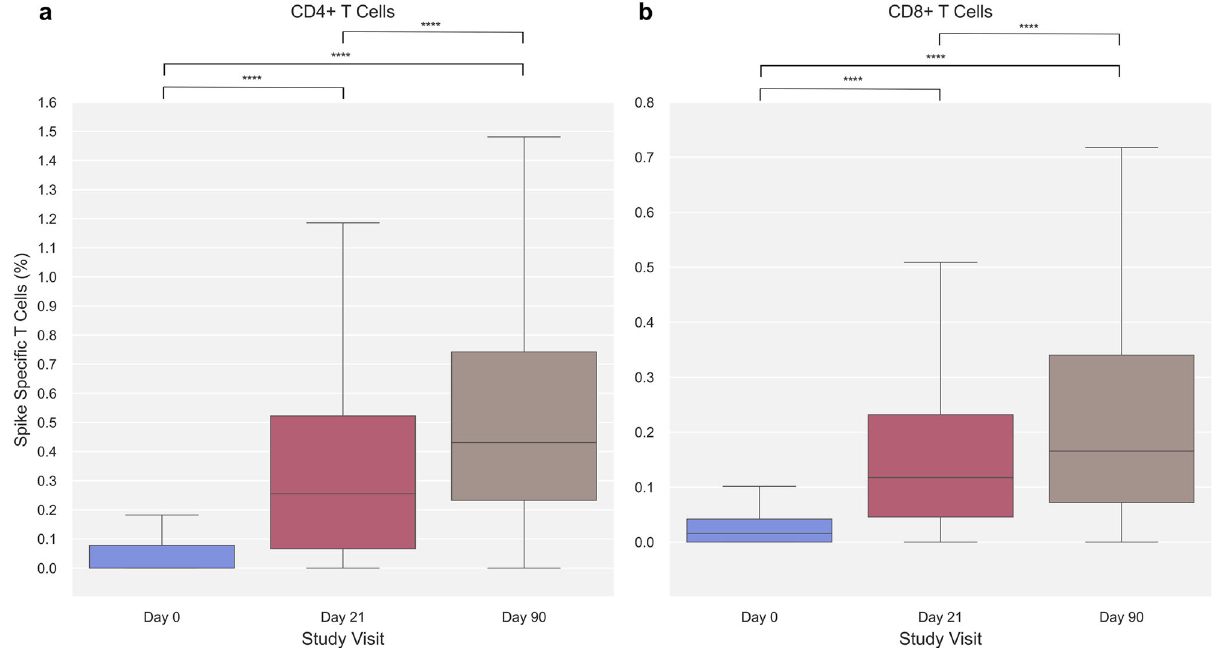
Fig. 1 SARS-CoV-2 Spike-speci fi c T cells at each study visit. a SARS-CoV-2 Spike-speci fi c CD4 + T cells at day 0 (blue), 21 (red), and 90 (brown) ( n = 286, 460, and 462, respectively). b SARS-CoV-2 Spike-speci fi c CD8 + T cells at day 0 (blue), 21 (red), and 90 (brown) ( n = 272, 444, and 449, respectively). Data was compared using unpaired, non-parametric Mann – Whitney U -test. Error bars show the distribution within 1.5 times IQR. p